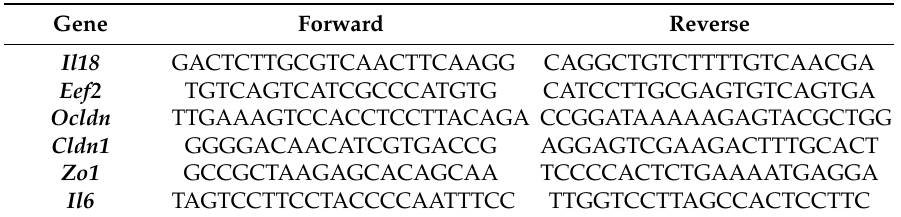
Table 2. Mouse primers